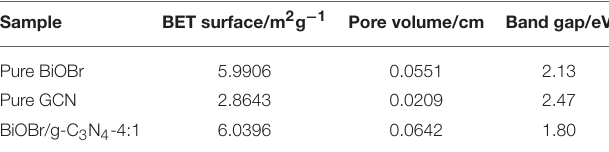
TABLE 1 | The parameters obtained from the nitrogen adsorption/desorption of